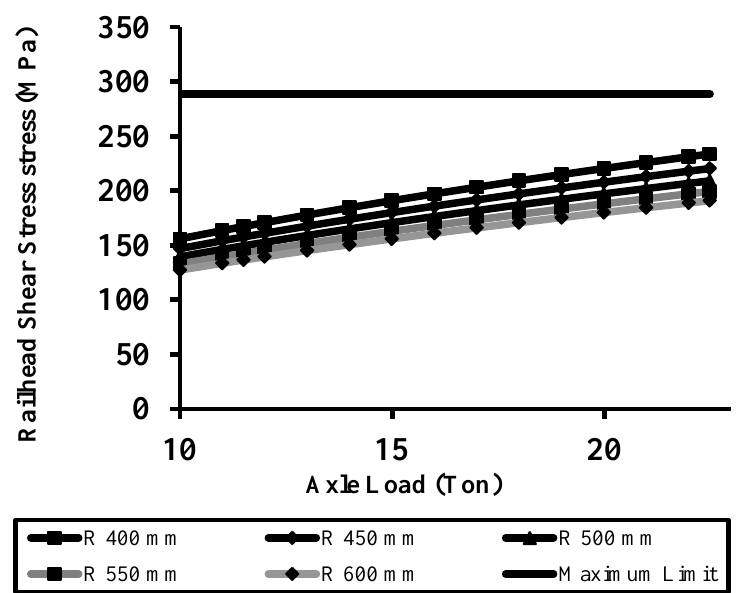
Fig. 4. Shear stress variation in railhead for different wheel